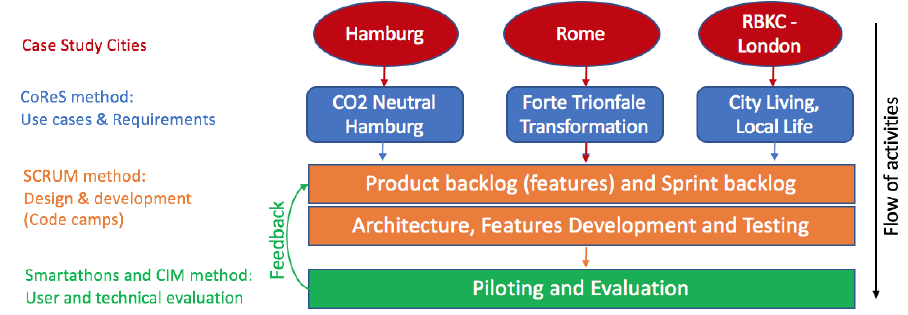
Figure 1. Depicts the overall smarticipate system development methodology.